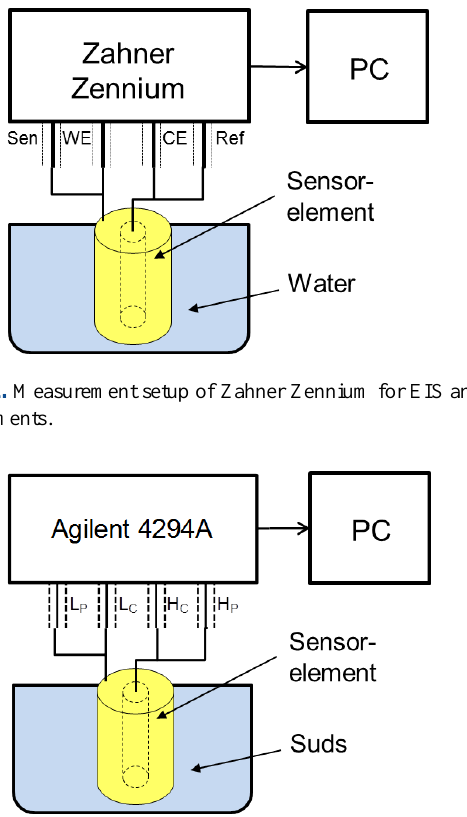
Figure 3. Dependence if the impedance spectra on total hardness of water.